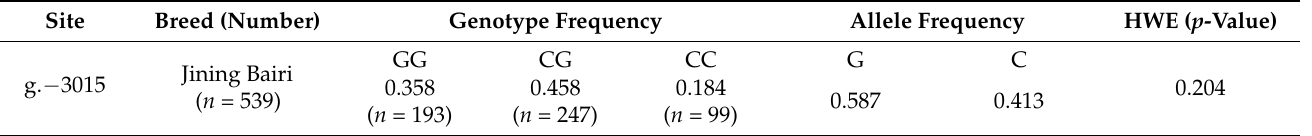
Table 2. Genotype and allele frequencies at the SNP site of the WNT4 gene in the Jining Bairi